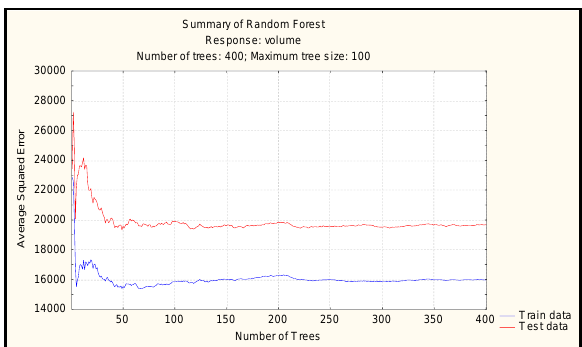
Figure. 2: average squared error changes in the number of trees for volume